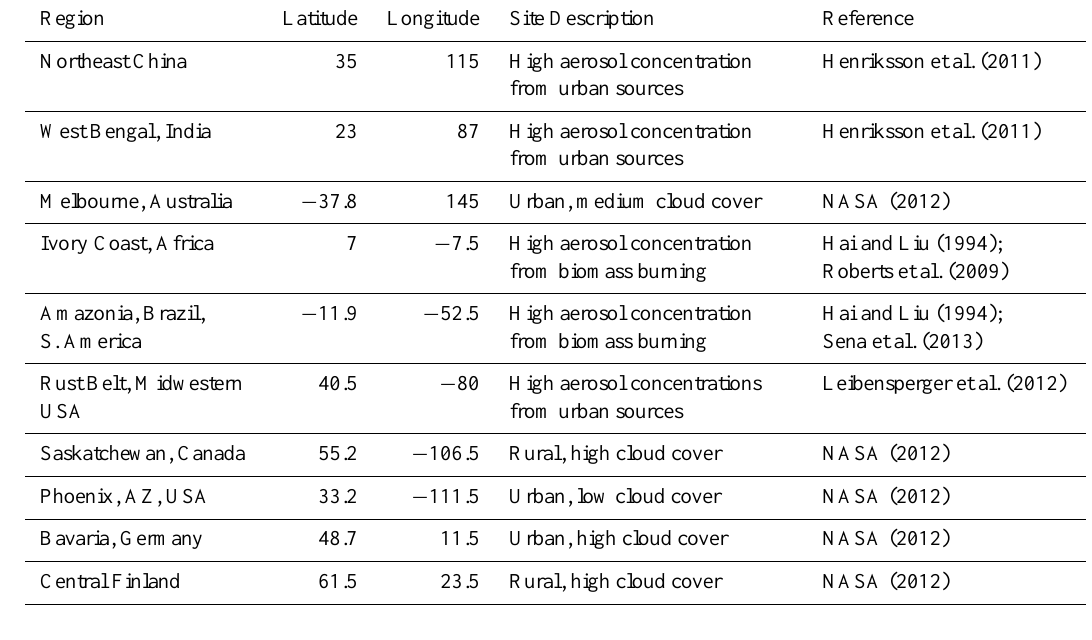
Table 1. Case study regions and their center pixel geographic coordinates. Region